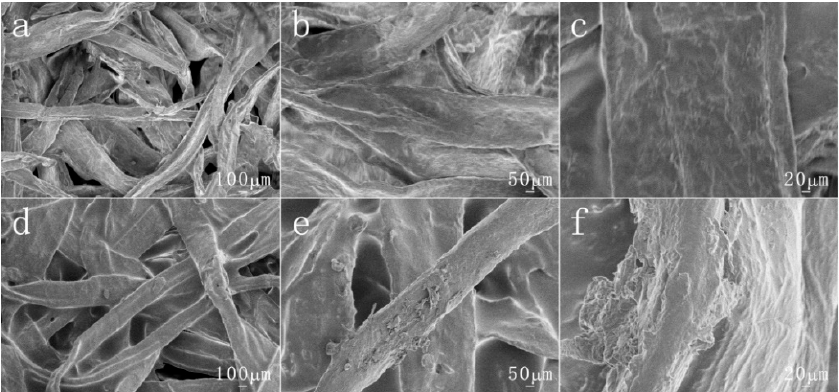
Figure 4. The different magnifications of SEM images of ( a – c ) pristine paperand ( d – f ) the copolymer coated paper.